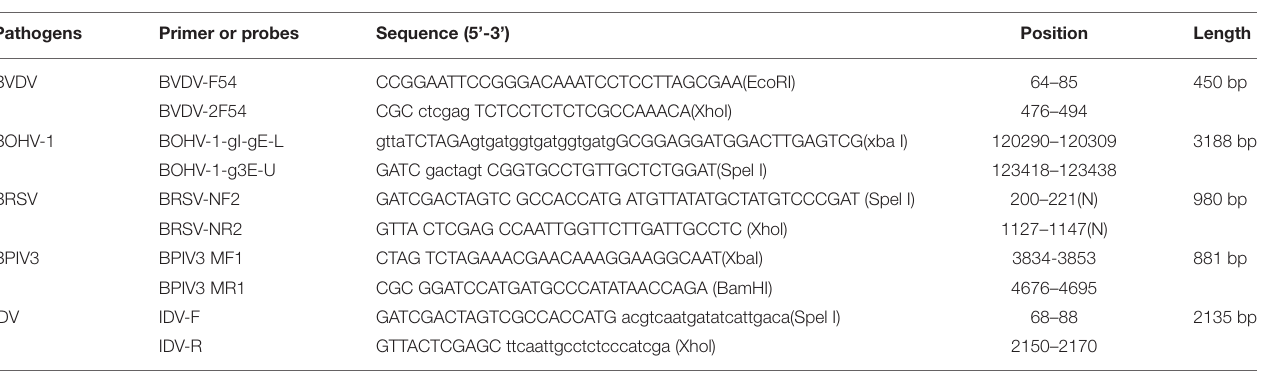
TABLE 2 | Primers used for standard